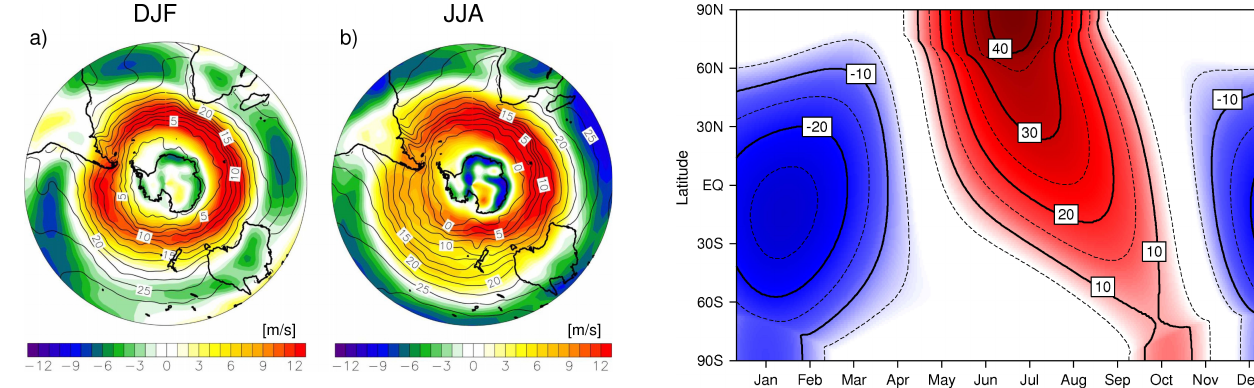
Fig. 1. Present-day Southern Hemisphere zonal wind climatology at 850hPa for (a) austral summer (DJF) and (b) austral winter (JJA), based on NCEP/NCAR reanalysis data (1968–1996; Kalnay et al., 1996). Overlaid isotherms (contours) represent the climatological sea surface temperatures ( ◦ C) for the corresponding seasons based on the NODC World Ocean Atlas (Levitus et al., 1998). During DJF, the northern margin of the zonal wind shows a more southward confined pattern, while during JJA, it extends further to the north. In general, the surface westerly winds cover the region between ∼ 30 ◦ S and 70 ◦ S, with the present-day strongest wind centred at around ∼ 50 ◦ S.